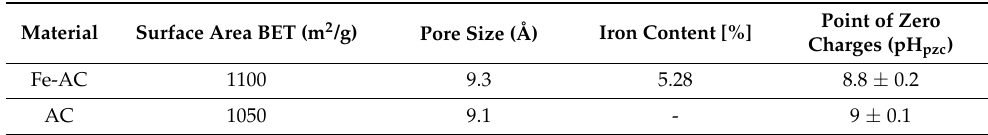
Table 2. Some physicochemical properties of Fe-AC.